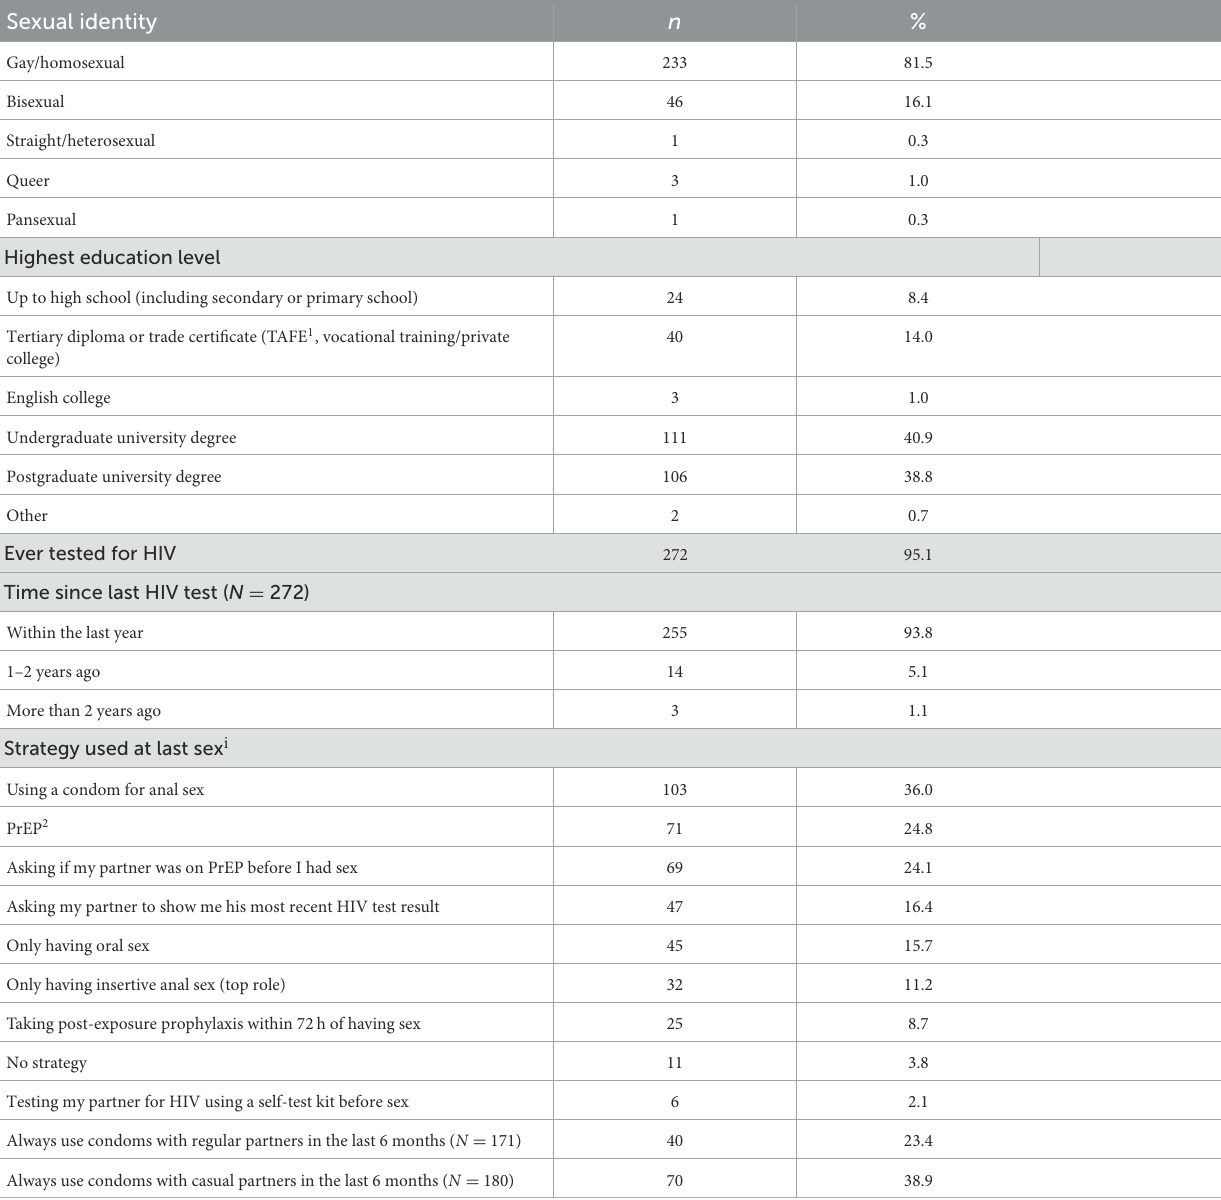
TABLE 2 Sociodemographic characteristics of the study population ( N = 286). Sexual